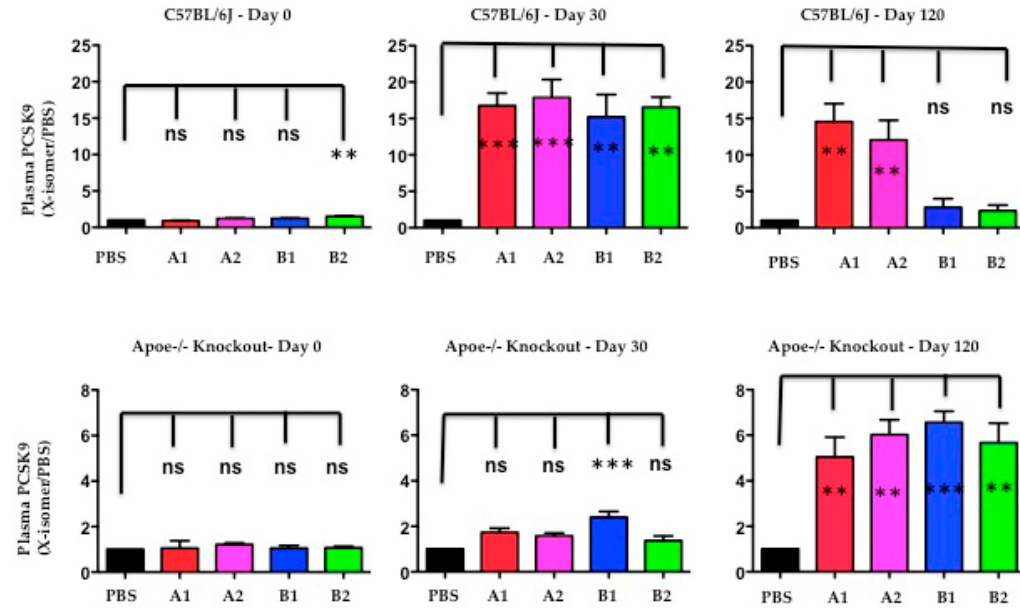
Figure 8. The levels of plasma PCSK9 proteins were significantly induced after immunogen treatment in both C57BL/6 and Apoe − / − knockout mice. Plasma of PBS and isomer treatment group (A1, A2, B1 and B2) at day-0 before treatment, day-30 and day-120 after treatment was subjected to resolve PCSK9 on SDS/10% PAGE, followed by Western blot analysis to determine the levels of PCSK9. The ratios of each treatment group/PBS are presented as mean ± SEM (black = PBS; red = X-PCSK9-A1; pink = X-PCSK9-A2, blue = X-PCSK9-B1 and green = X-PCSK9-B2). The authors used One-way ANOVA statistical analysis with Dunnett’s multiple comparison test to analyze the difference between X-PCSK9 isomers vs. PBS-treated groups. The statistical analyses were performed using GraphPad Prism software (version 5). The p value < 0.05 (**, ***) is considered significant.